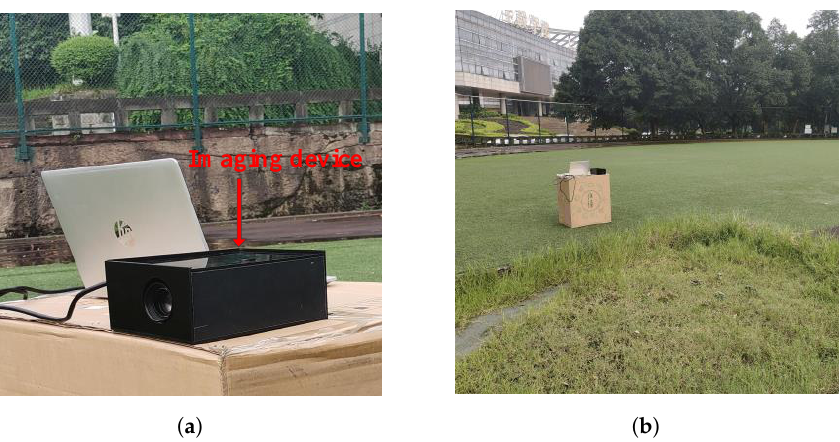
Figure 11. The imaging device based on raptor vision. ( a ) Optical imaging equipment. ( b ) Experi- mental